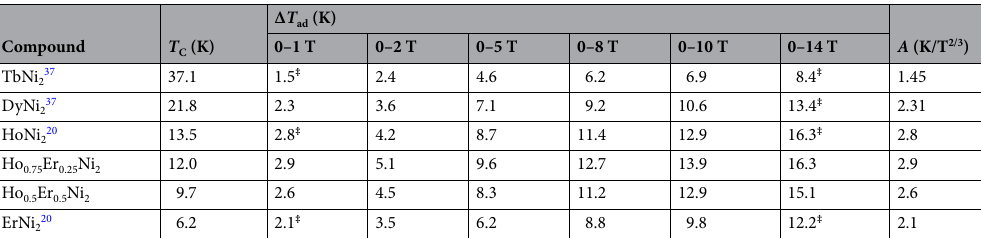
12 K and reaches 13.7 J/kgK at 7.7 K for Ho 0.25 Er 0.75 Ni 2 for a magnetic field change of 2 T. The maximum adiabatic temperature change Δ T ad for Ho 0.75 Er 0.25 Ni 2 in the 2-T magnetic field change is equal to 4.9 K at 12 K, and with increasing Er content, the Δ T ad value decreases to 3.9 K for Ho 0.25 Er 0.75 Ni 2 in the vicinity of T C . The maximum